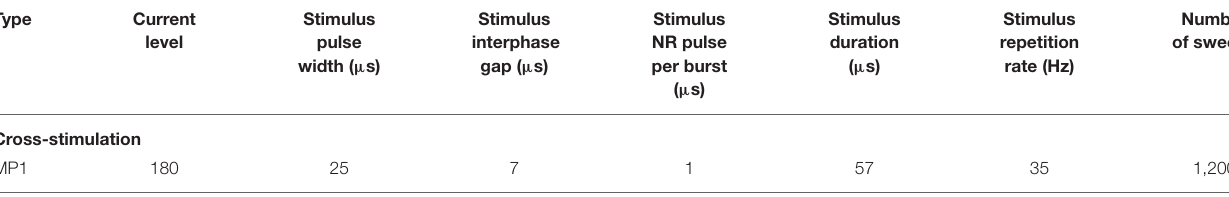
TABLE 3 | Parameters used in vestibular cross stimulation with cochlear implant. Type